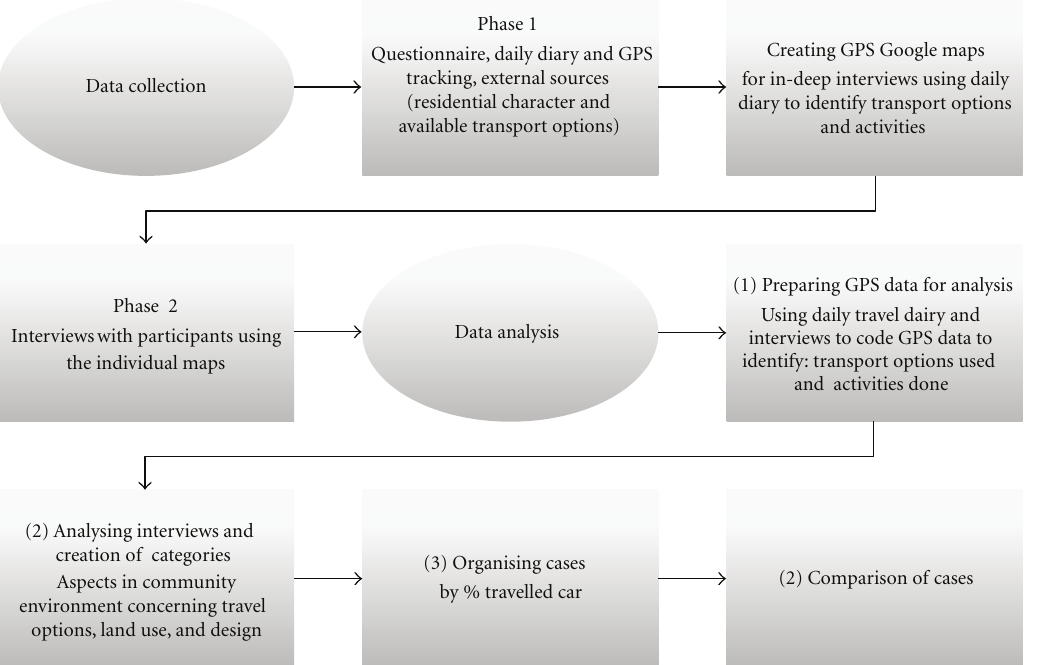
Figure 1: Data collection and analysis.